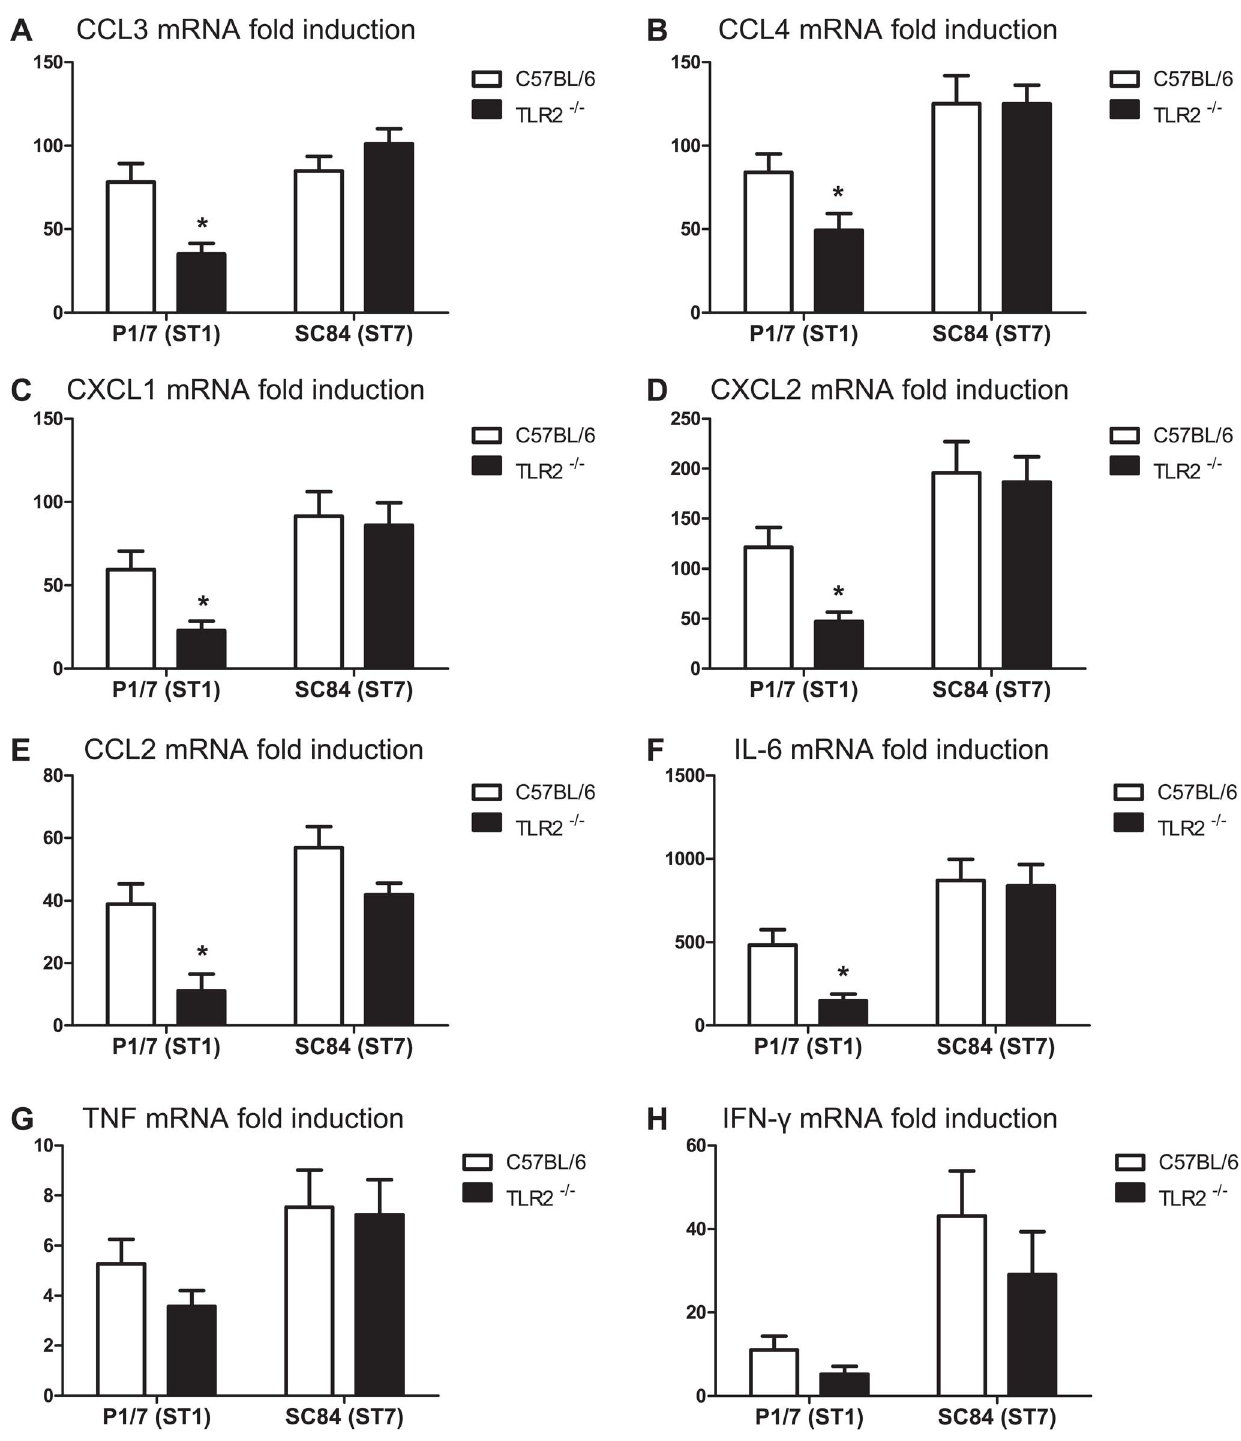
Figure 3. Proinflammatory cytokines and chemokines gene expression in TLR2 2 / 2 or wild-type mice infected with ST1 or ST7 strain. Proinflammatory cytokine and chemokine gene expression in TLR2 2 / 2 mice infected with S. suis highly virulent strain ST1 is lower than wild-type counterparts, whereas no major differences are observed between epidemic strain ST7-infected groups. Quantitative PCR analysis of cytokine and chemokine gene expression in C57BL/6 and TLR2 2 / 2 mice infected with 1 6 10 7 CFU of either S. suis strain P1/7 (ST1) or SC84 (ST7). Total RNA was isolated from spleen samples at 6 h post-infection. Tested cytokines and chemokines are indicated at the top of each panel. Data represent mean mRNA relative fold induction values 6 SEM. * P , 0.05, indicates TLR2 2 / 2 group significantly different from corresponding C57BL/6 mice as determined by t-test .